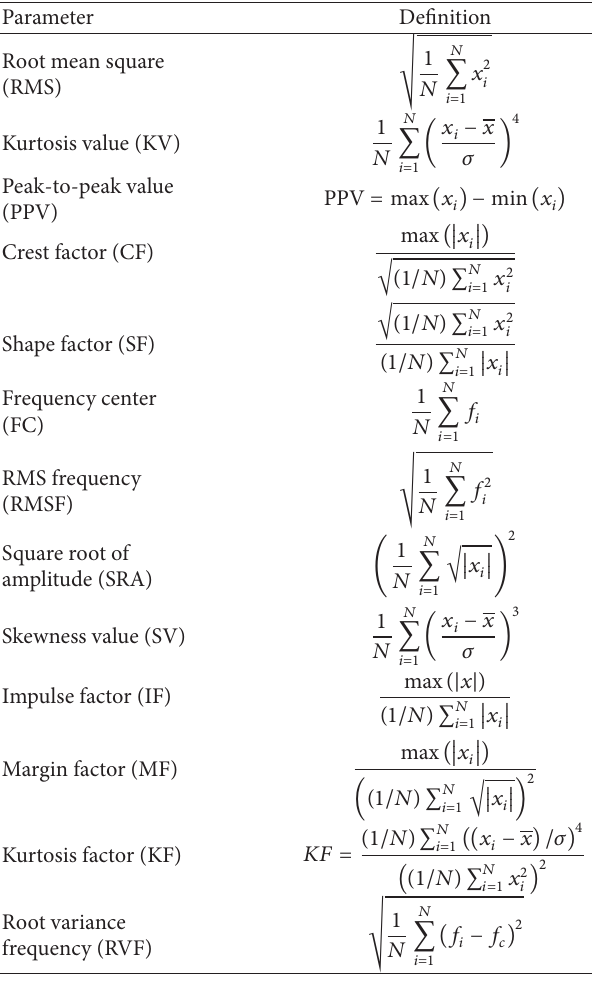
Table 2: Statistical measures calculated over the time and frequency domain AE